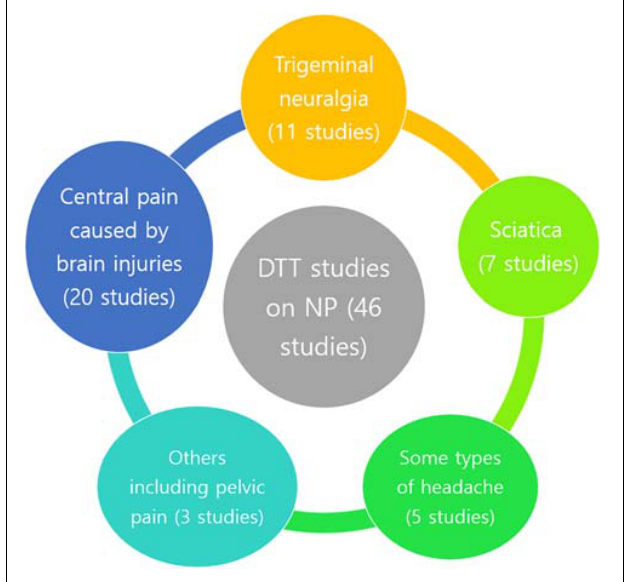
FIGURE 2 | Diffusion tensor tractography studies on NP. DTT, diffusion tensor tractography; NP, neuropathic